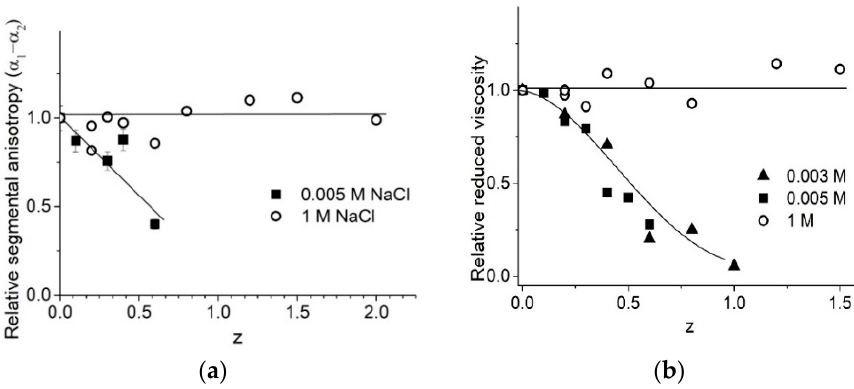
Figure 9. Dependence of relative change in optical anisotropy of DNA statistical segments ( a ) and reduced viscosity of DNA solutions ( b ) on z value at varied [NaCl] (as depicted).